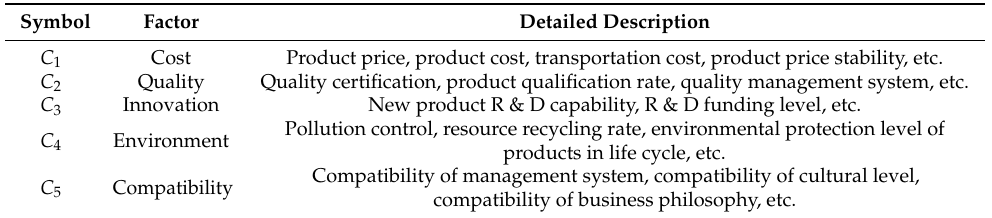
Table 1. Supplier Evaluation factor system.